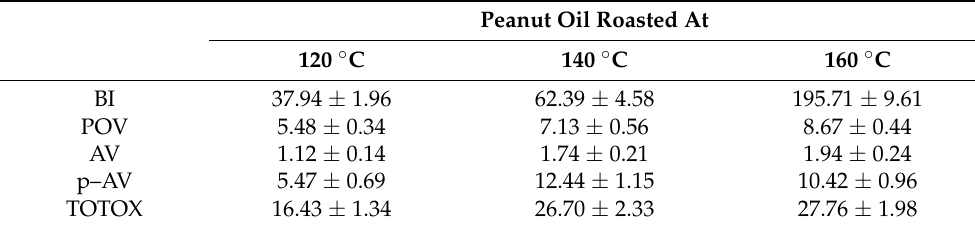
Table 1. Quality indices in peanut oils was influenced by roasting temperatures.